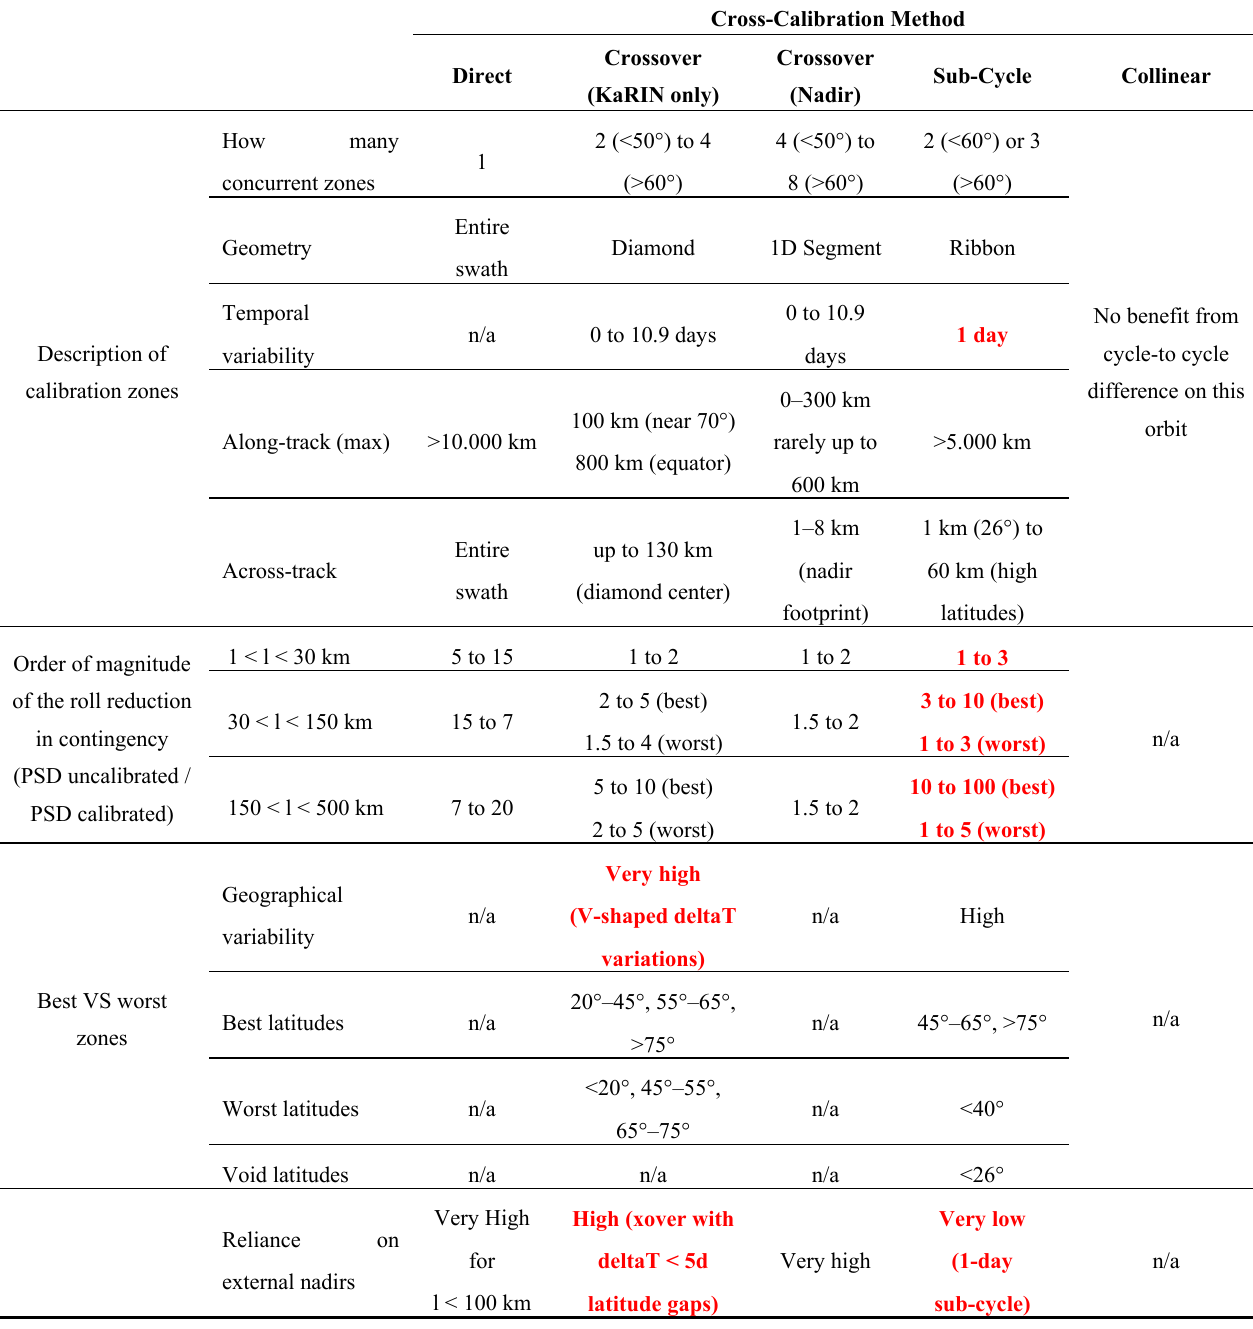
Table 2. Synthesis for contingency orbit (21-day repeat, 1-day